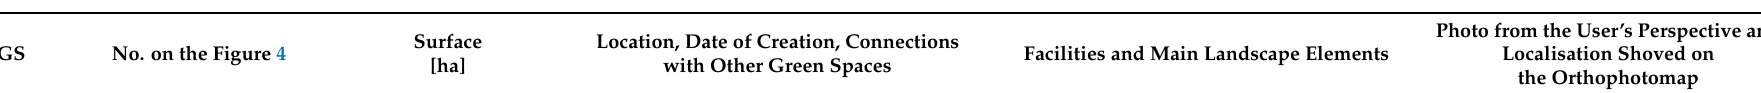
Table 3. Characteristics of representative PGSs from the study area and the buffer